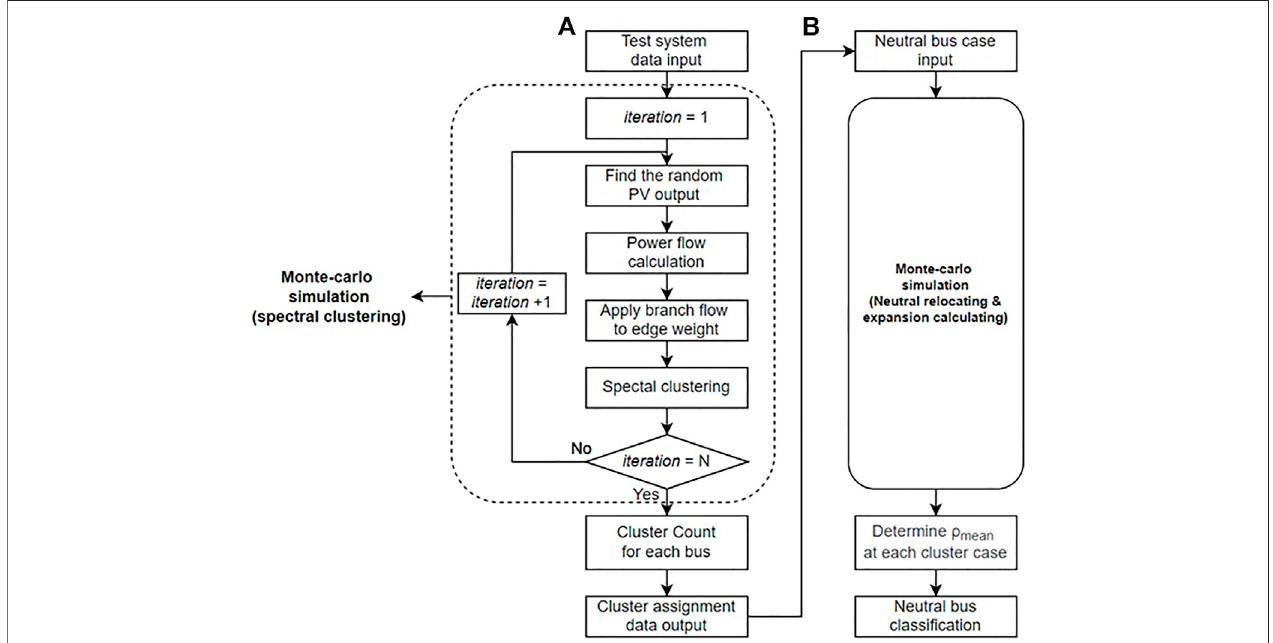
FIGURE 3 | Proposed methodology. (A) Probabilistic spectral clustering algorithm. (B) Neutral bus classi fi cation.